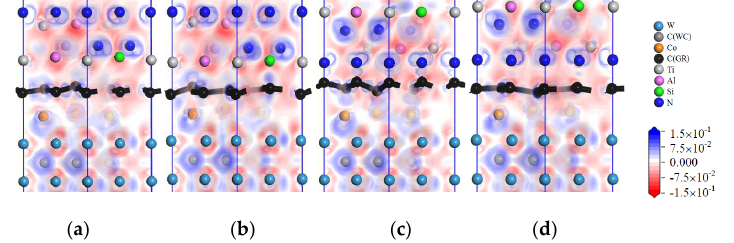
Figure 14. Charge-density difference image of interface models with defective graphene doping in the coating/matrix interface: ( a ) TiAlSiN Si /svGR/WC-Co; ( b ) TiAlSiN Si /tdGR/WC-Co; ( c ) TiAlSiN N /svGR/WC-Co; ( d ) TiAlSiN N /tdGR/WC-Co. (2) Density of states (DOS) Analyzing the density of states can explore the bonding situation from the perspec- tive of electron orbital hybridization. Figure 15a,c are the images of the total density of states (TDOS) and the partial den- sity of states (PDOS) of the interface models without doping graphene. At the Fermi lev- el, the TDOS of the interface models is not zero, indicating a metallic character for the interface. As shown in Figure 15a, the remarkable DOS feature of TiAlSiN Si /WC-Co is that its peak is mainly contributed by p orbital electrons of Ti atoms and W atoms, and the interaction between Si and Co at the interface is mainly the hybridization of p elec- trons of Si and d electrons of Co, forming Si/Co covalent bonds. Figure 15b,d are the images of TDOS and PDOS of the interface models with the matrix doped with msGR. In Figure 15b, the density of states of Al, Si, and Co atoms of TiAlSiN Si /WC/msGR/Co overlaps in the range −5 ~5 eV, and the orbital hybridization is generated by Al-s, Si-s, and Co-d, forming Al/Co bonds and Si/Co bonds. Compared with Figure 15a without gra- phene doping, the covalent effect of the Si/Co bond is stronger, which explains the es- sential mechanism that the adhesion work value of TiAlSiN Si /WC/msGR/Co is higher than that of TiAlSiN Si /WC-Co. A shown in Figure 15c, the remarkable feature of the density of states of TiAlSiN N /WC-Co is that its peak is mainly contributed by p orbital electrons of Ti and W atoms, and the interaction between N and Co at the interface is mainly the hybridization of p electrons of N and d electrons of Co, forming N/Co covalent bonds. In Figure 15d, at the TiAlSiN N /WC/msGR/Co interface, the density of states of N and Co atoms overlaps on the left side of Fermi level, and N-s and Co-d produce orbital hybridization, forming N/Co bonds. On the left side of Fermi level, the density of states of the C atom, Co atom, and W atom is orbitally hybridized by C-p with Co-d and W-d, forming C/Co and C/W